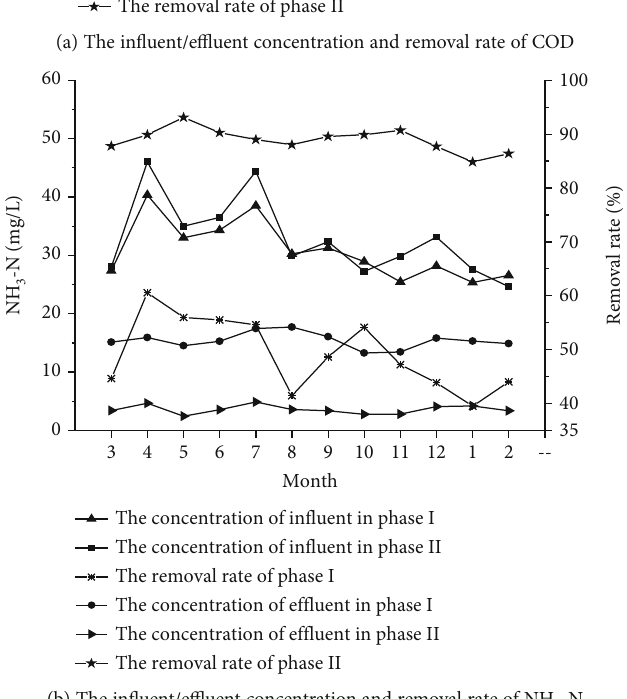
(b) The in fl uent/e ffl uent concentration and removal rate of NH 3 -N Figure 6: